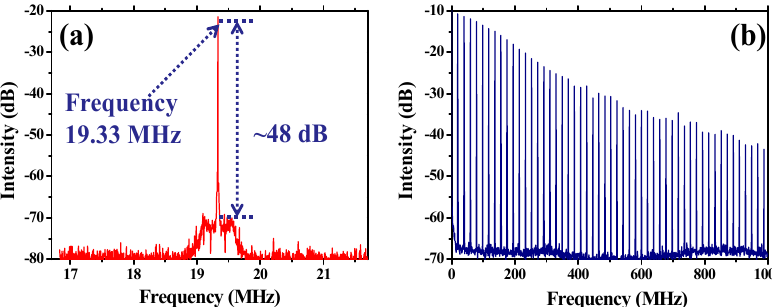
Figure 9. ( a ) The RF spectrum of the output laser at maximal output power recorded within a bandwidth of 5 MHz under a resolution of 1 kHz at the central frequency; ( b ) the RF spectrum within a spectral bandwidth of 1 GHz.